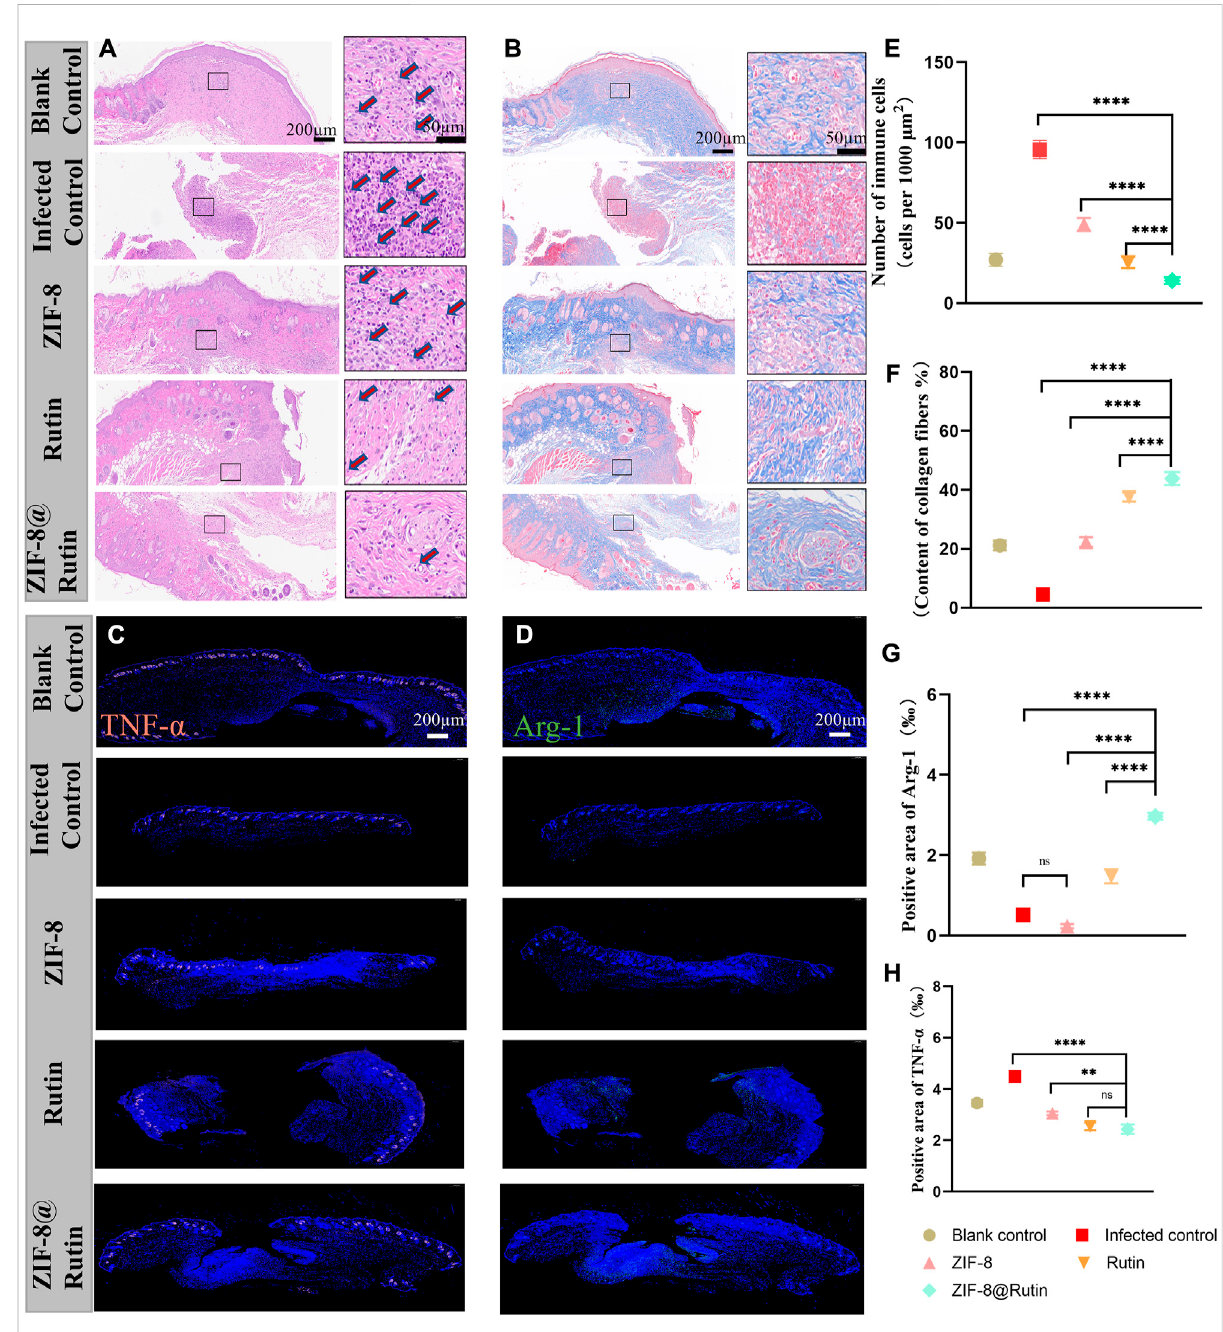
Histological evaluation of cutaneous wounds on the back of mice treated with different nanoparticle simulations. H&E (A) and Masson ’ s trichrome staining (B) of local peri-wound tissue on day 10. Immuno fl uorescence images of TNF- α (C) and Arg-1 (D) expression in wounds. In (C,D) , immuno fl uorescence staining (red) showed TNF- α -positive cells, and immuno fl uorescence staining (green) showed Arg-1-positive cells and DAPI staining (blue). Quantitative analysis of in fl ammatory cells in H&E samples from different nanocomposite treatment groups (E) and